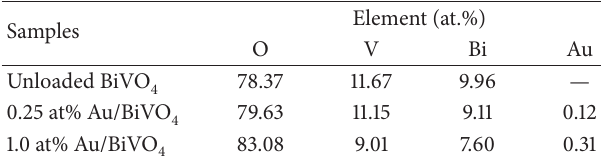
Table 1: The content of synthesized pure BiVO powders determined by EDX Au/BiVO 4